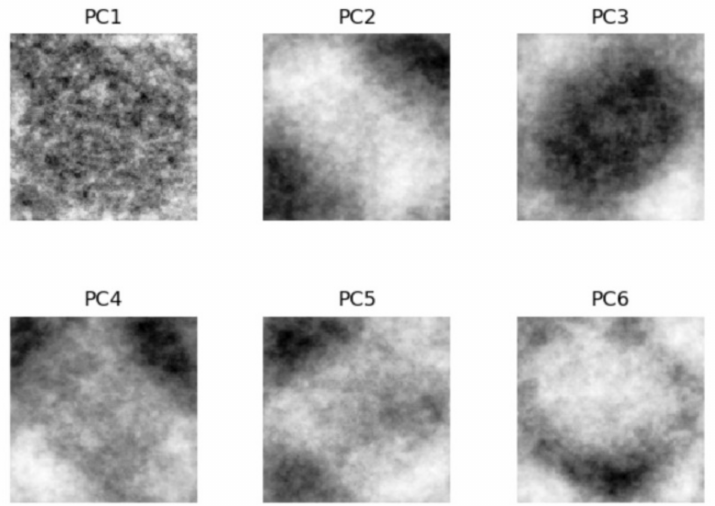
PCA analysis. This analysis is trained in the experiment dataset with a reconstruction loss function. Brighter pixels indicate higher numeric values in contrast to dimmer values that indicate low numeric values at that location.